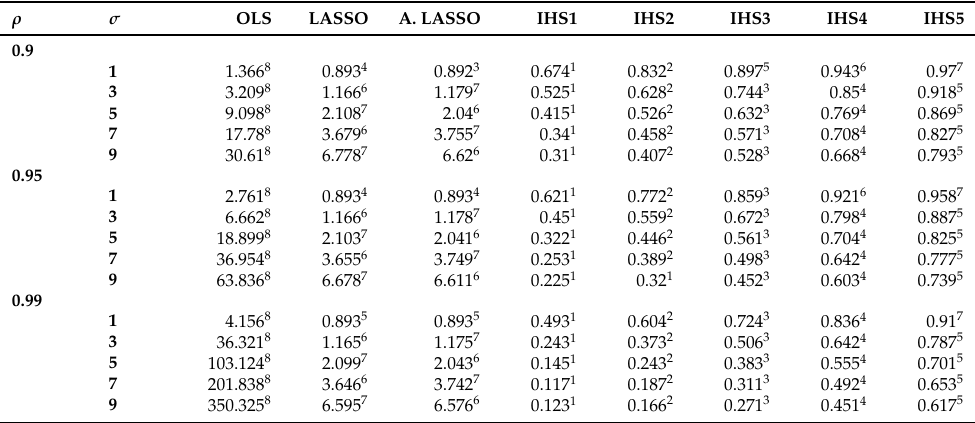
Table 6. Estimated MSEs for n = 150 and p = 8 (superscript represents